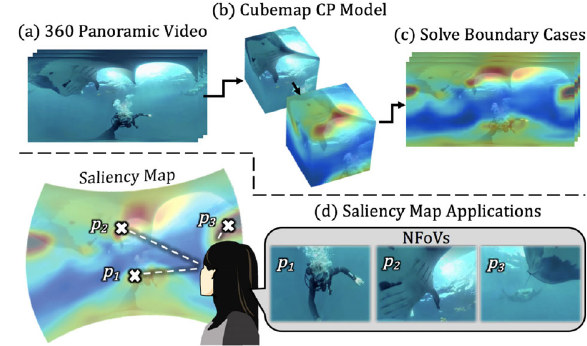
Fig. 9 Saliency detection in 360 ◦ video using cube padding. (a) A frame in equirectangular projection. (b) Cubemap projection with cube padding (CP) to mitigate distortion and cuts at image boundaries. High-quality saliency maps are predicted on the cubemap. (c) Predicted equirectangular saliency map. (d) Desirable NFOVs obtained from the high-quality saliency map. Reproduced with permission from Ref. [107], c (cid:2) Institute of Electrical and Electronics Engineers